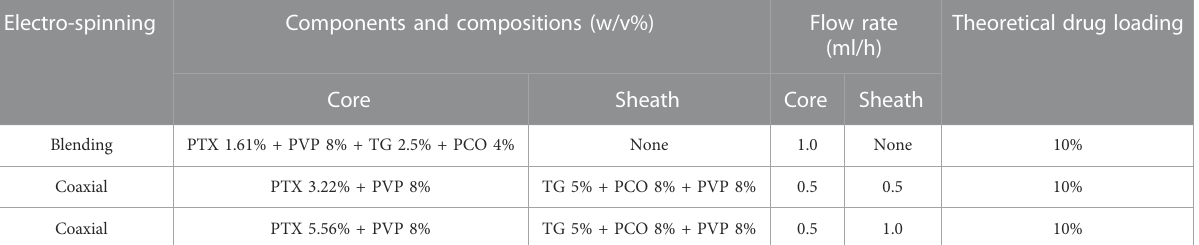
TABLE 1 Detailed preparation parameters of nano fi bers. No.